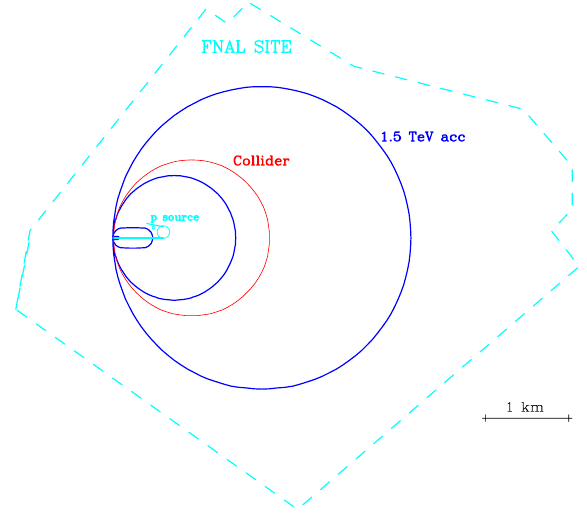
FIG. 3. (Color) Plan of a 3 TeV COM muon collider shown on the Fermi National Laboratory site as an